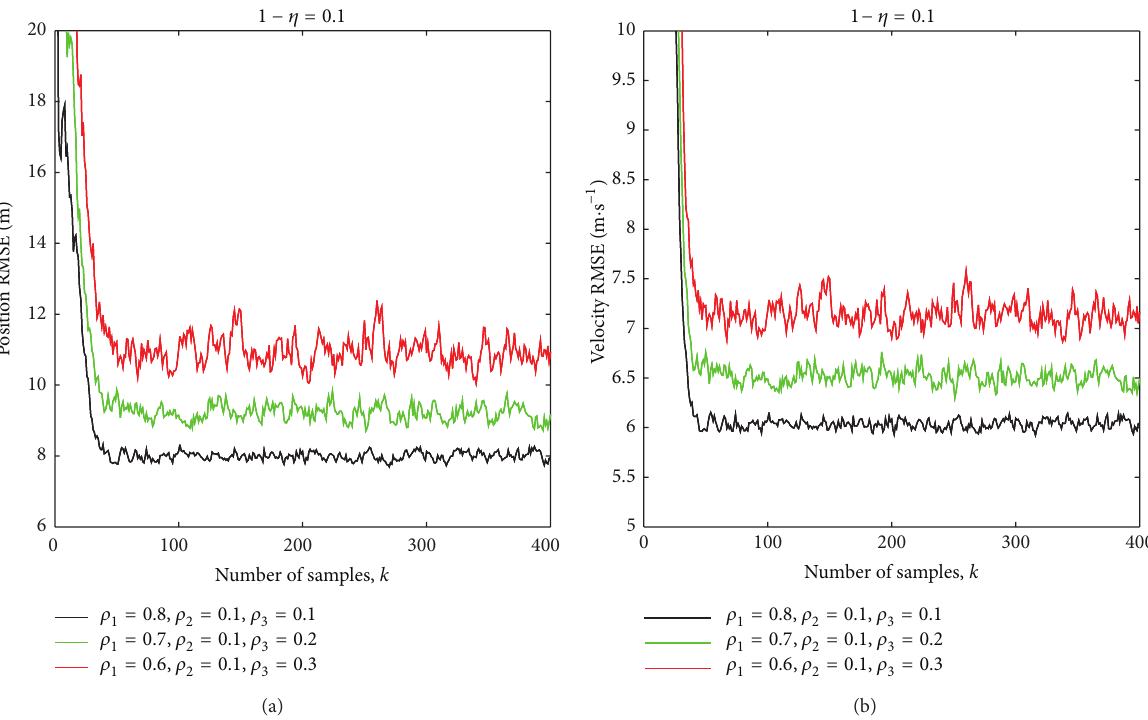
Figure 5: Comparison of the RMSEs for the proposed algorithm with different 𝜌 𝑞 (𝑞 = 1, 2,3) : (a) position RMSE; (b) velocity RMSE.